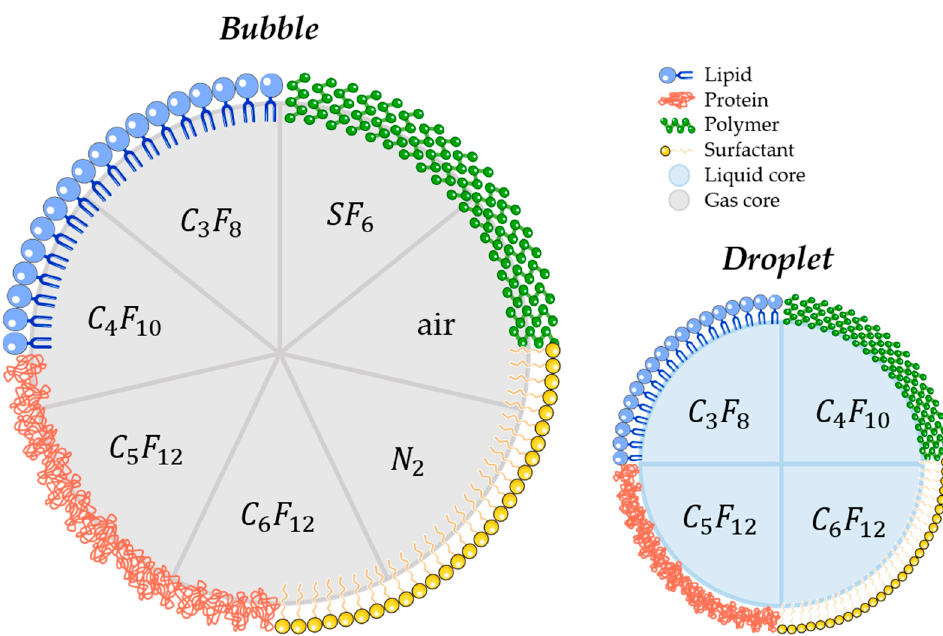
Figure 4. Schematic illustration of most commonly used materials for shell and core composition of agents used for FUS-induced BBB. ( C 3 F 8 octafluoropropane; C 4 F 10 : decafluorobutane; C 5 F 12 : dodecafluoropentane; C 6 F 12 : perfluoromethylcyclopentane; SF 6 : sulphur hexafluoride; N 2 : nitrogen).